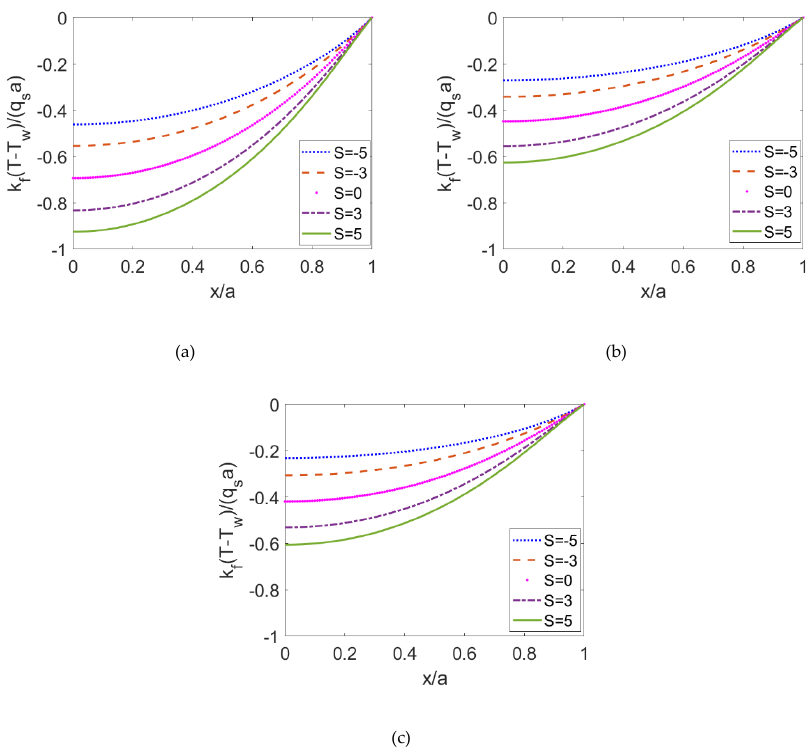
Figure 7. The comparison among temperature profiles at y = 0 for di ff erent Joule heating parameters in the case of ( a ) n = 0.8, ( b ) n = 1.0 and ( c ) n = 1.2.